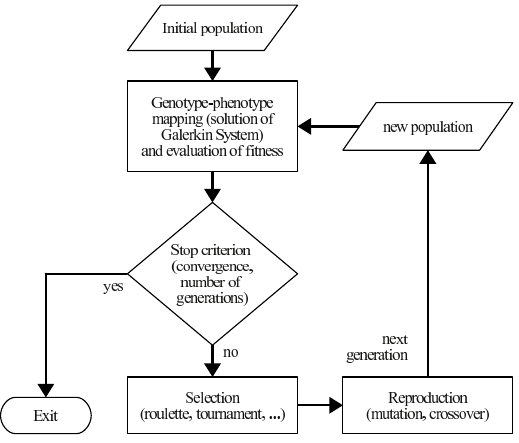
Figure 2. Flow chart of genetic